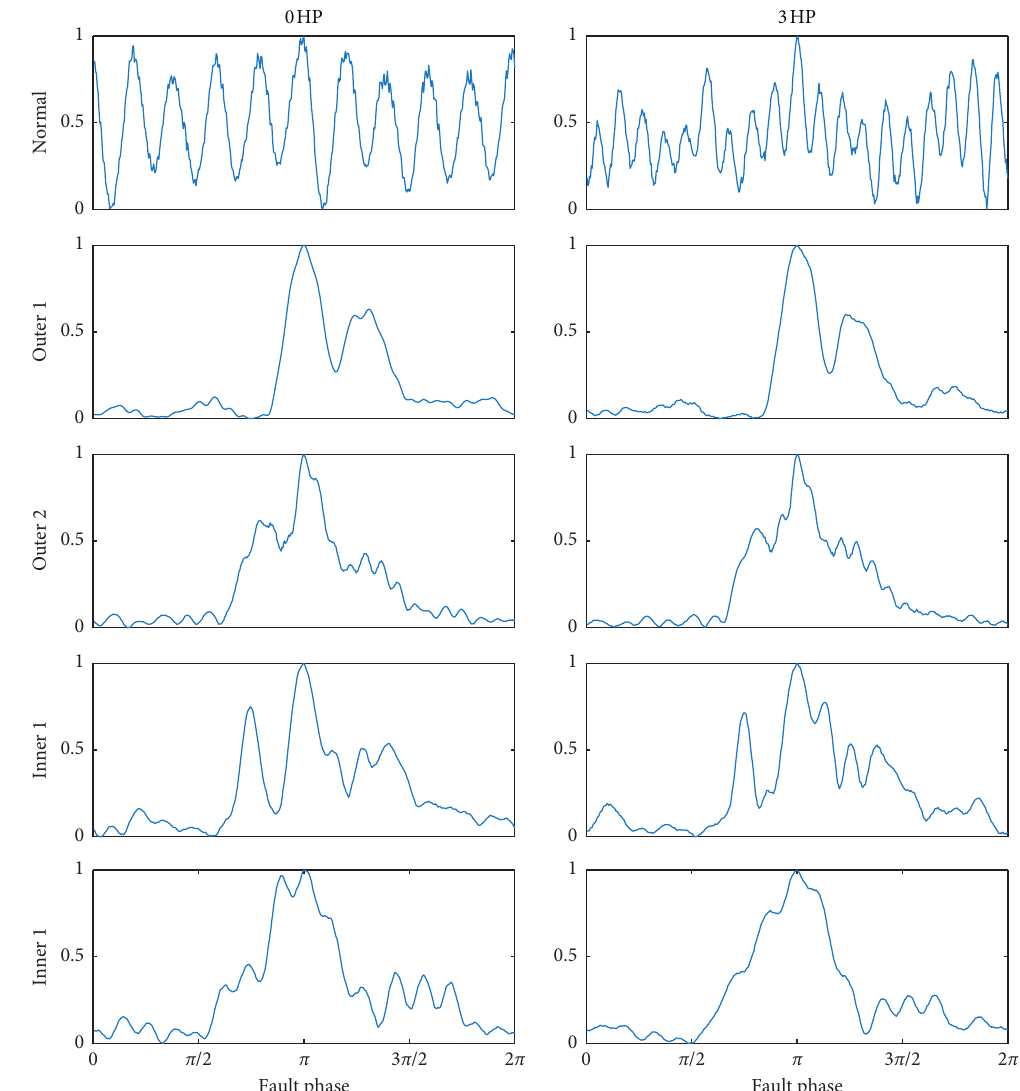
Figure 23: Feature extraction results using correct FCCs under different working conditions.